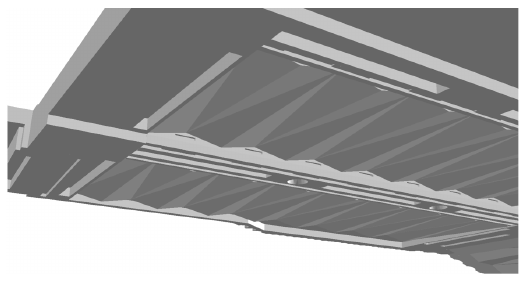
Figure 5. Ticket hall ceiling- elements lost in